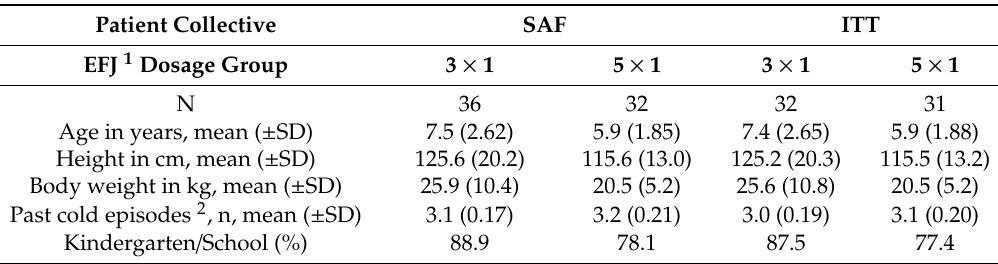
Table 1. Baseline demographic characteristics of all children included in the safety collective (SAF) and intention-to-treat collective (ITT).